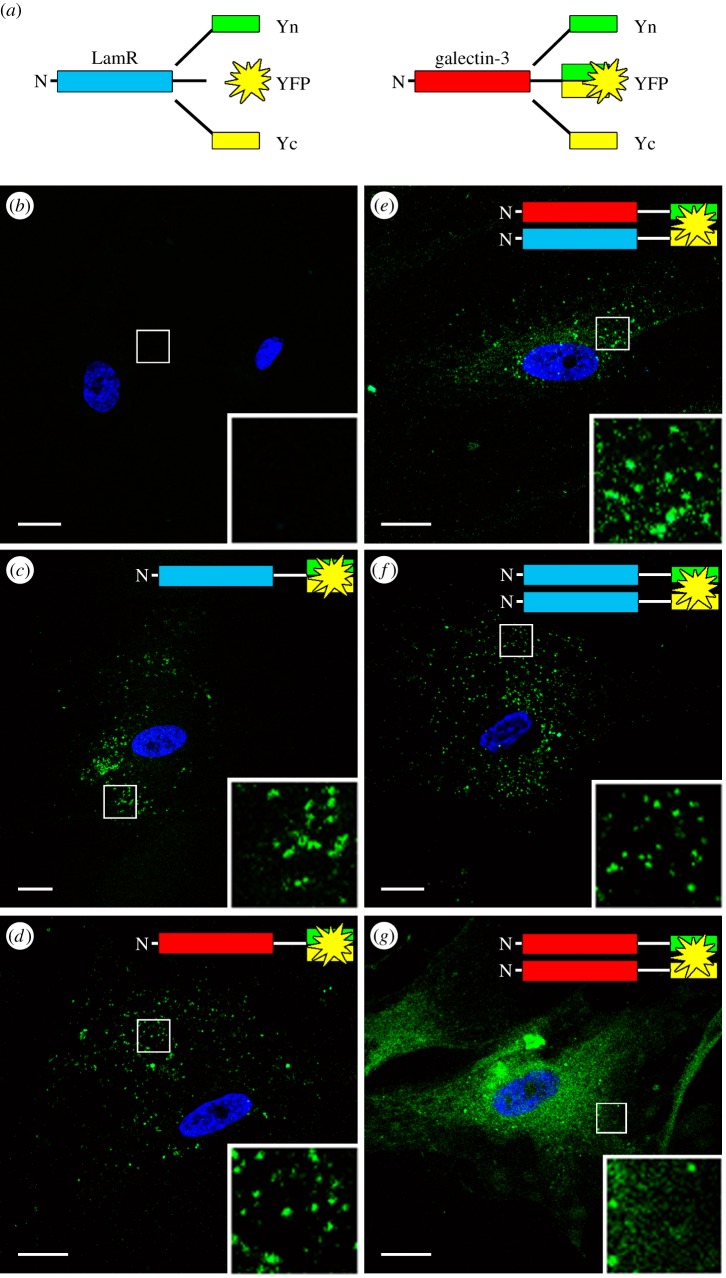
37LRP/Gal-3 hetero- and 37LRP/37LRP homodimerization is confirmed by BiFC analysis. (a) A schematic showing the different constructs used for transfection and subsequent BiFC analysis. LamR (magenta) or galectin-3 (red) cDNA was cloned in frame with Yn, YFP or Yc. Cells were then transfected as indicated (b–g) and allowed to express for 24 h prior to fixation and confocal analysis. Merged images also show Hoechst 33258 DNA staining. Scale bar, 10 mm. Insets are shown at 4× original magnification. Images are representative of ≥3 independent experiments.